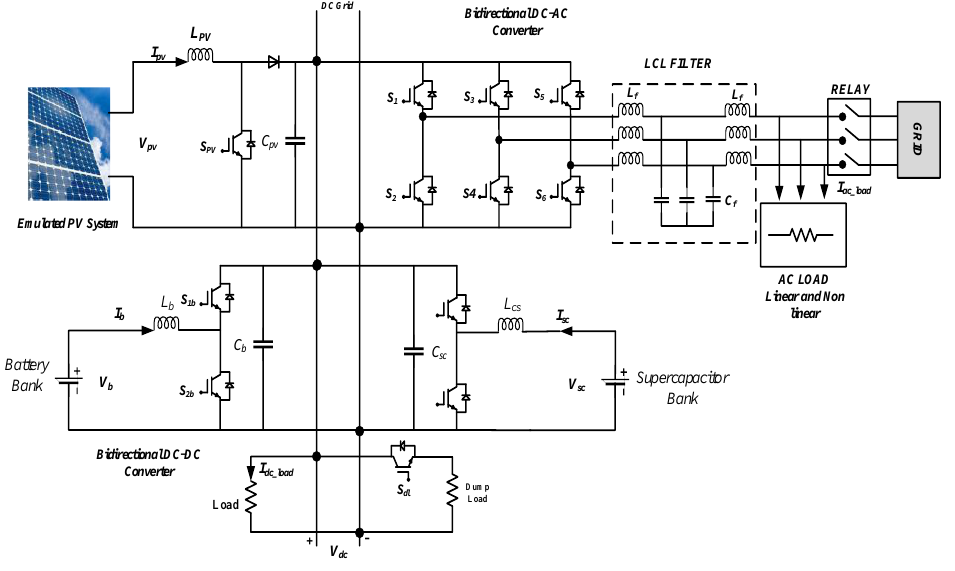
Figure 1. DC microgrid system architecture.